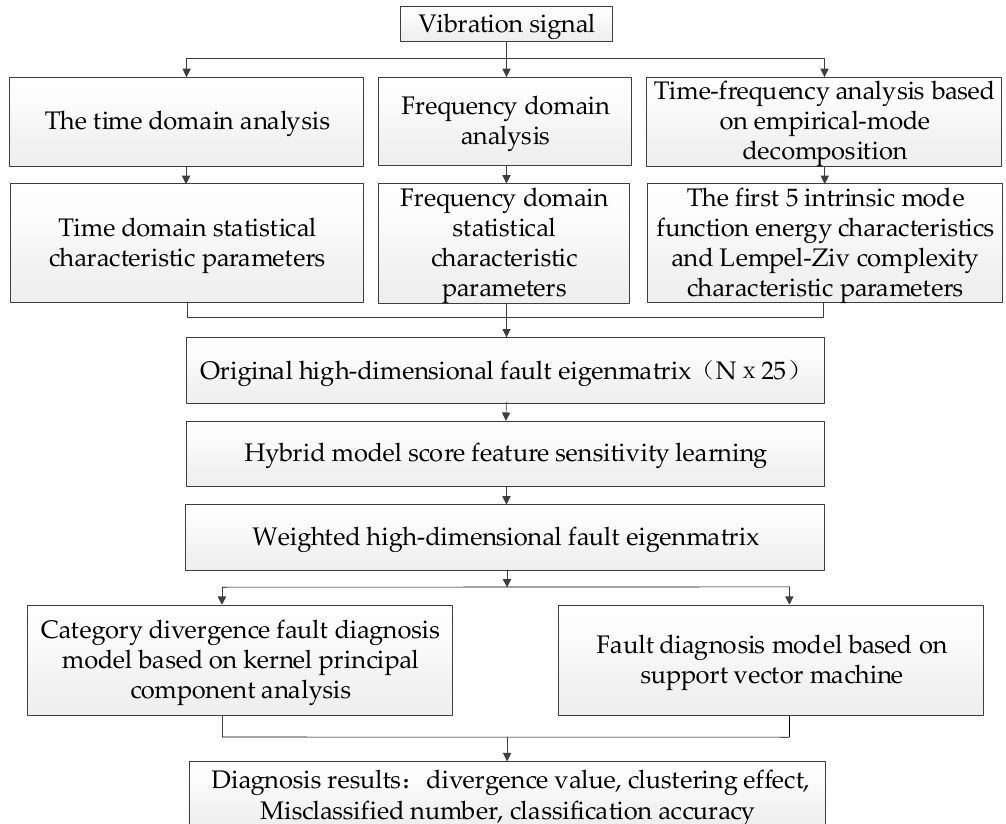
Figure 2. Flowchart of diagnosis based on multi-measurement hybrid-feature evaluation.